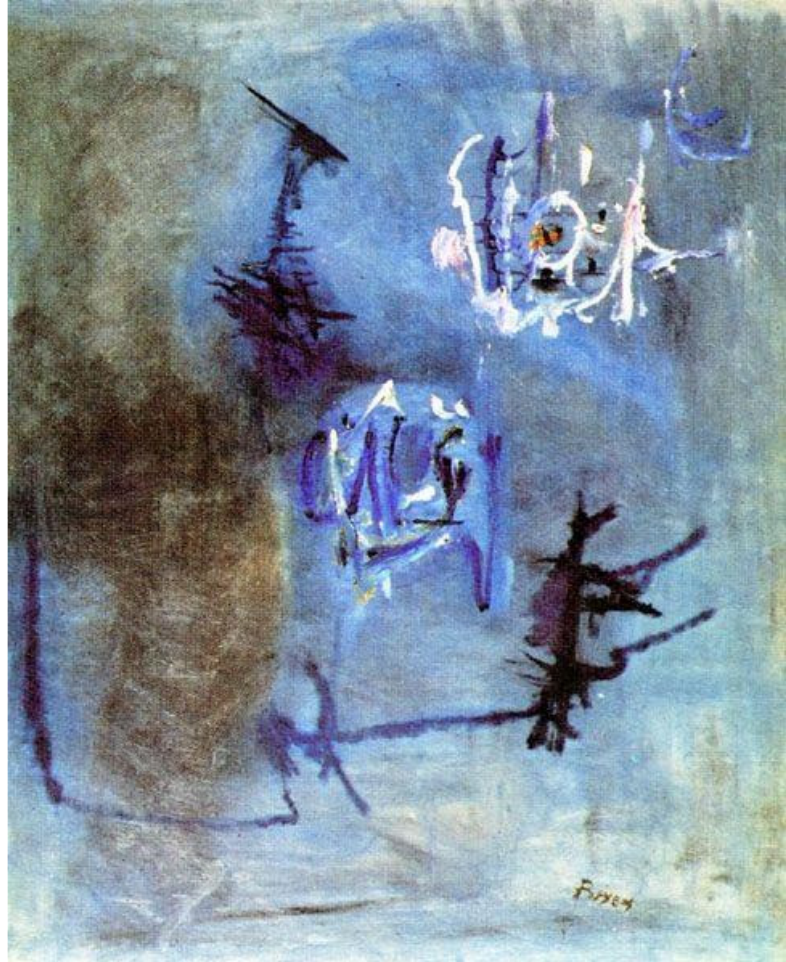
Figure 5. Camille Bryen, Tellurie , 1952. Oil on canvas, 100 × 81 cm. Nantes, Musée des Beaux-Arts. Copyright: ADAGP.